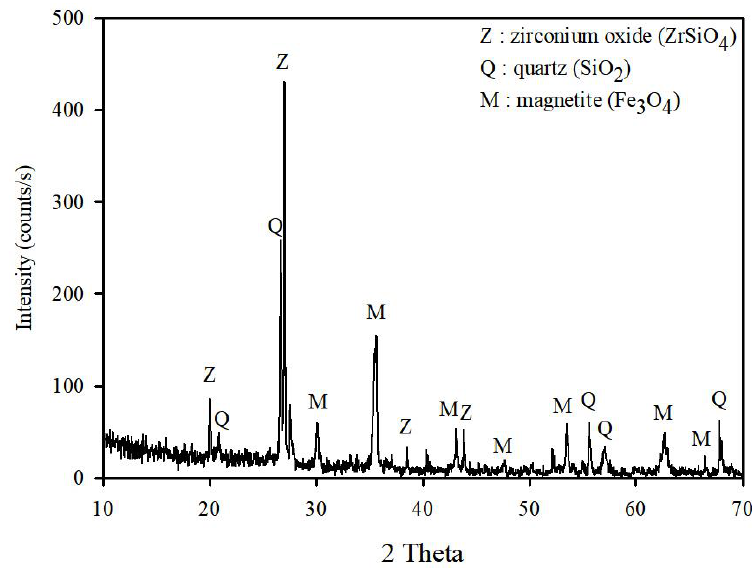
Figure 3. X-ray diffraction patterns of WFD.